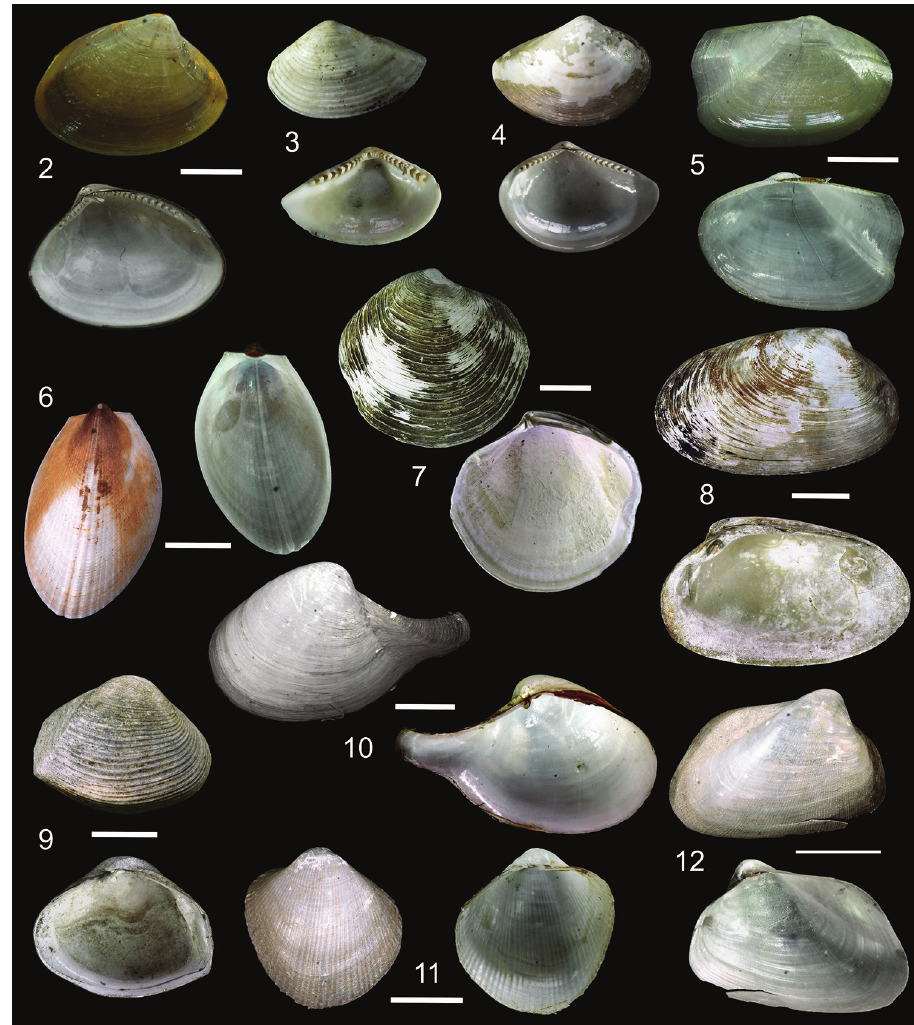
Figure 2–12. 2 Exterior and interior views of Ennucula panamina 3 Jupiteria lobula (total length = 4.2 mm) 4 Neilonella cf. atossa (total length = 5 mm) 5 Malletia goniura 6 Limatula cf. saturna 7 Lucinoma heroica 8 Calyptogena cf. gallardoi 9 Carycorbula sp. 10 Cuspidaria panamensis 11 Dallicordia alaskana 12 Lyonsiella cf. magnifica . Scale bars: 2, 5, 6, 9, 11 5 mm. 7, 8, 10, 12 10 mm.